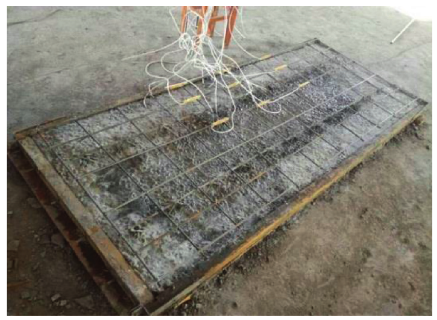
Figure 4: Reinforcement on LPCSHTHSC casting layer.